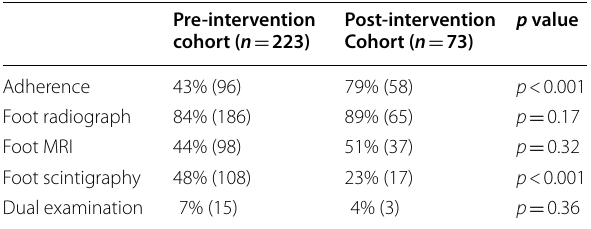
Table 3 Comparison between the hospital imaging related fees for the pre‑ and post‑intervention